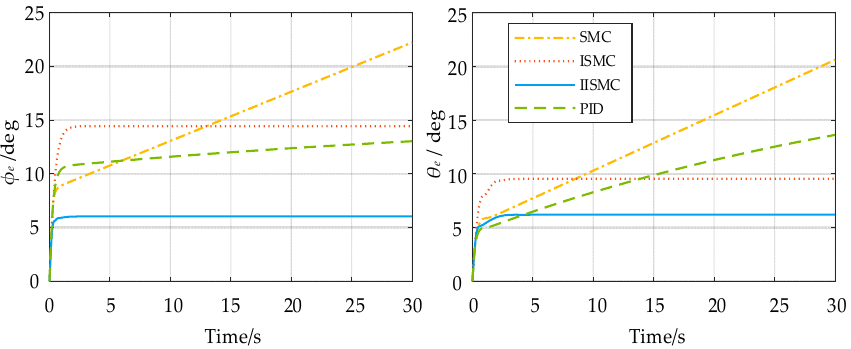
Figure 11. Cumulative attitude angles error under four control methods in Scene 2. On the basis of steady-state interference, random noise and sinusoidal interference are added to simulate the wind and wave environment in Scene 3. All the methods